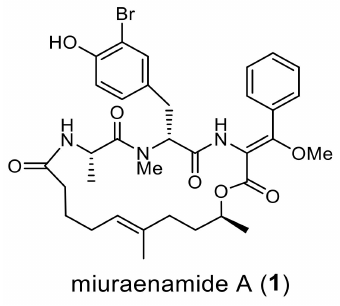
Figure 1. Chemical structure of miuraenamide A ( 1